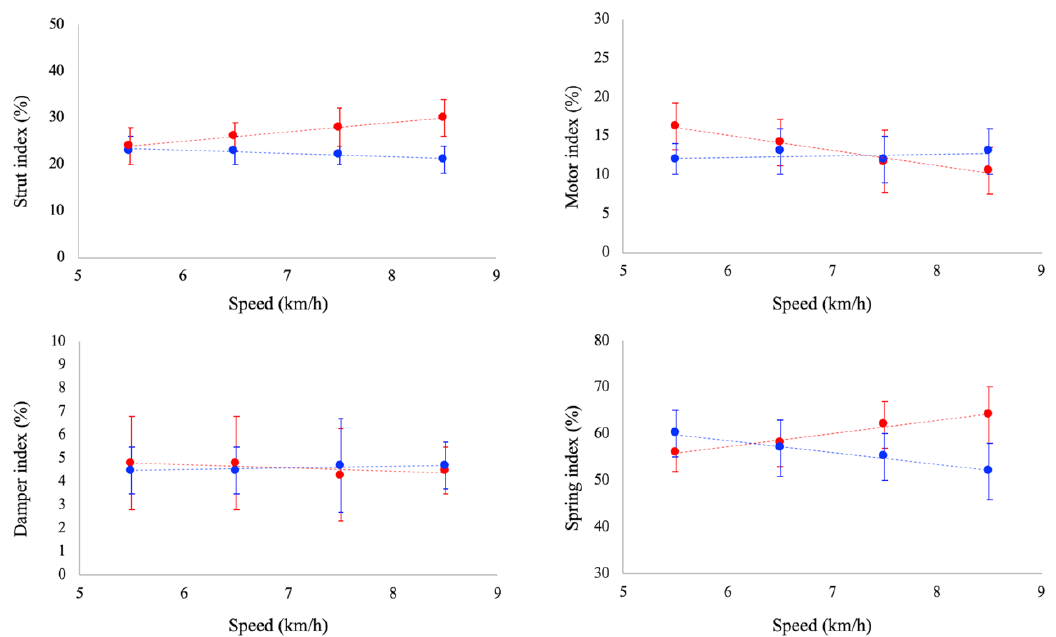
Figure 3. Joint functional indexes (in the stance phase) during walking (blue dots) and running (red dots) at the investigated speeds. Data are means ±SD.